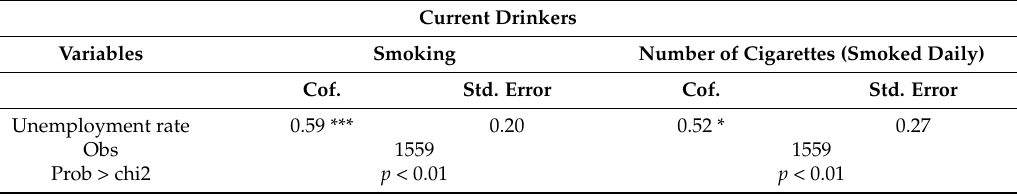
Table 6. Effects of unemployment rate on smoking behavior of drinkers and